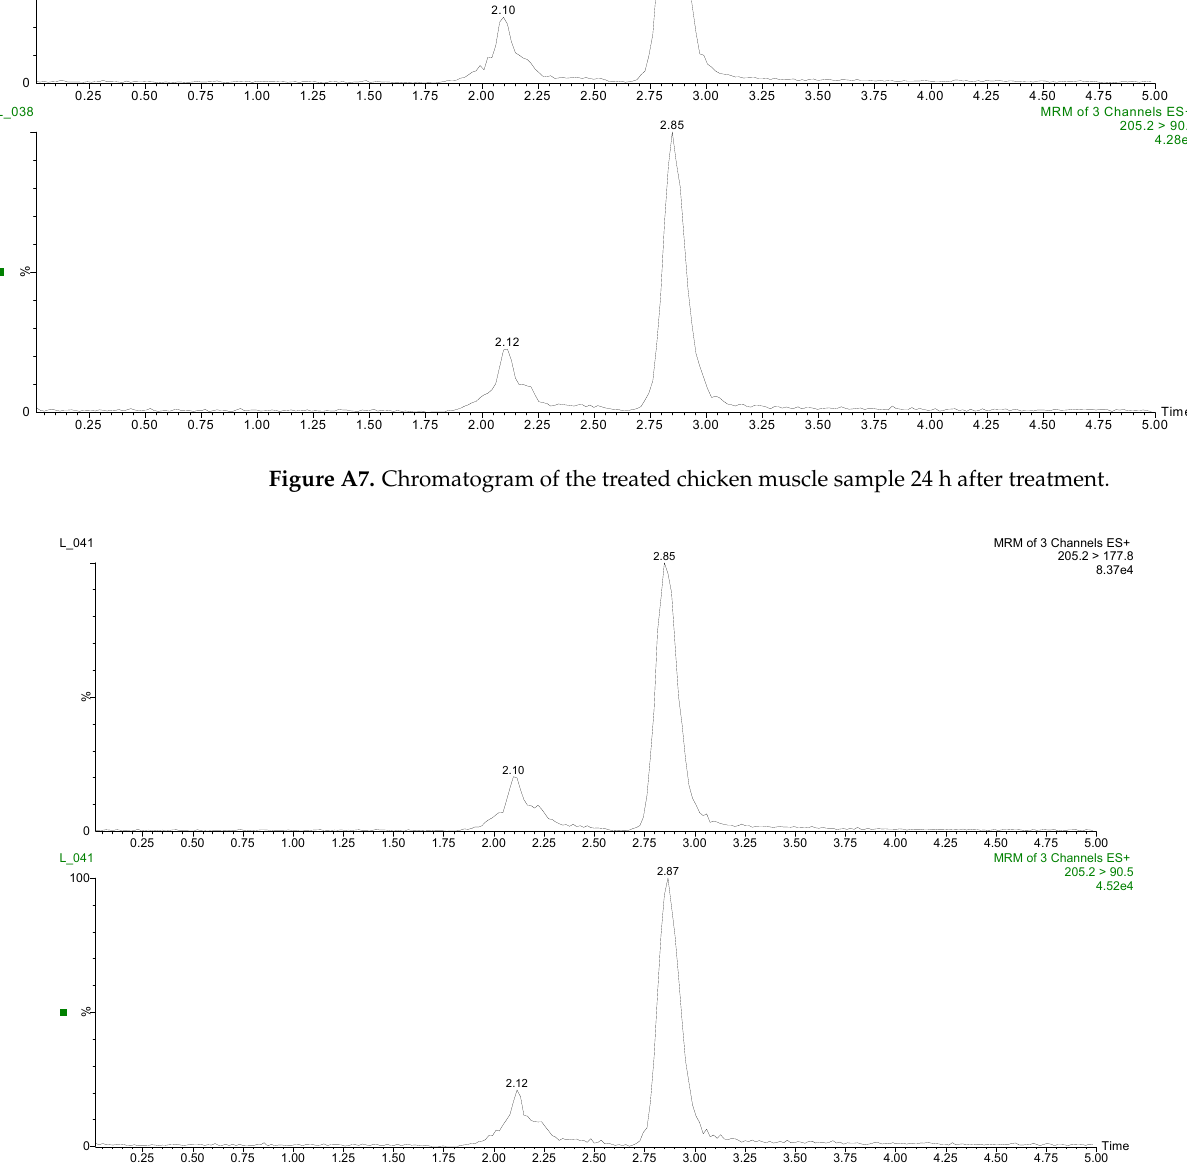
Figure A9. Calibration curve for levamisole (0–100 μ g/kg). References 1.